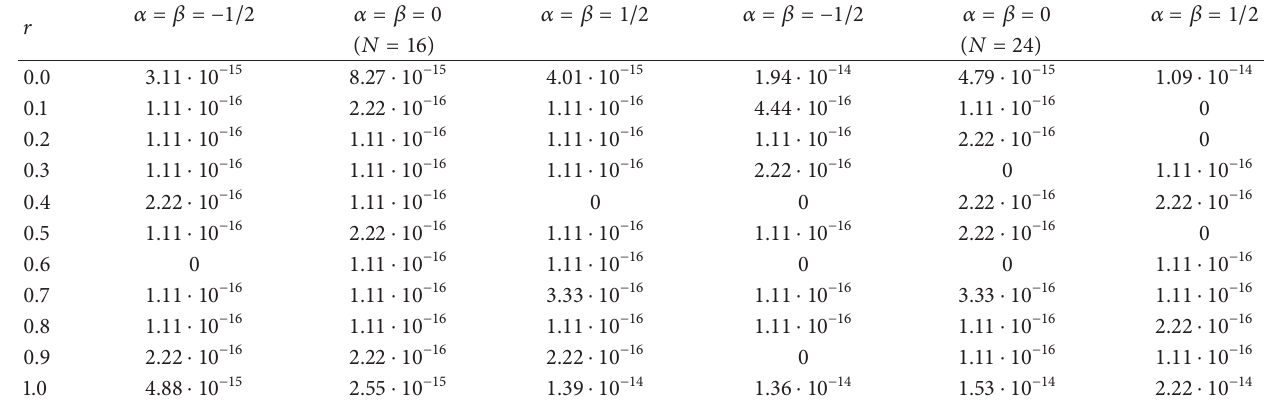
Table 5: Absolute residual error functions for 𝑛 = 7/3, 𝜆 = 1/3 .